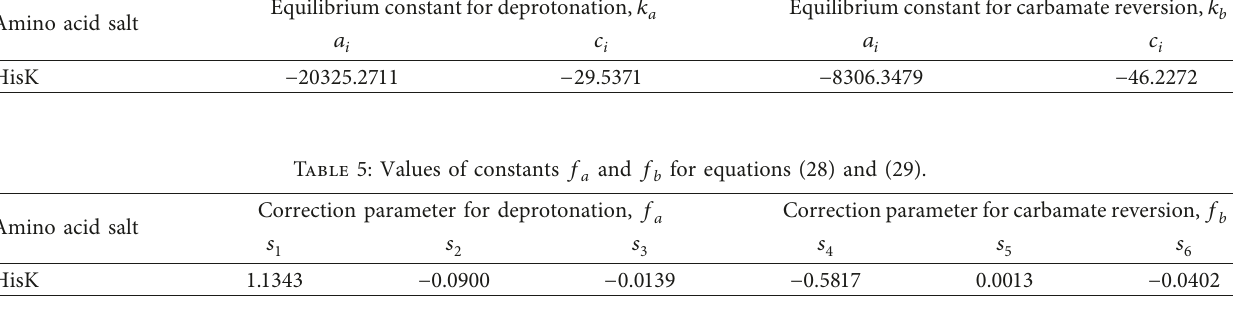
Table 4: Values of constants k